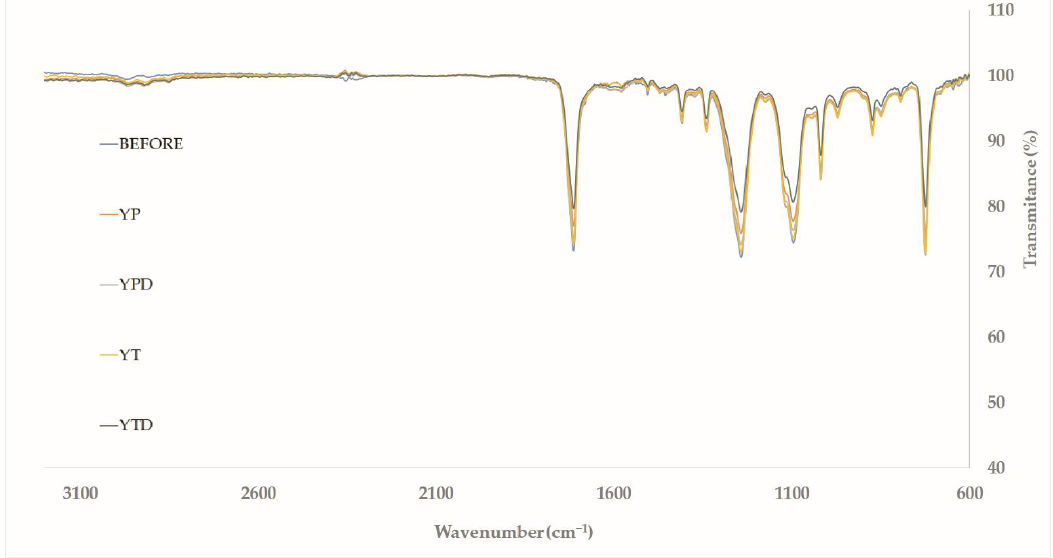
Figure 8 . ATR-FTIR spectrum before and after biodepolymerization during submerged cultures of Y. lipolytica IMUFRJ 50682 at 28 °C and 250 rpm for 96 h.